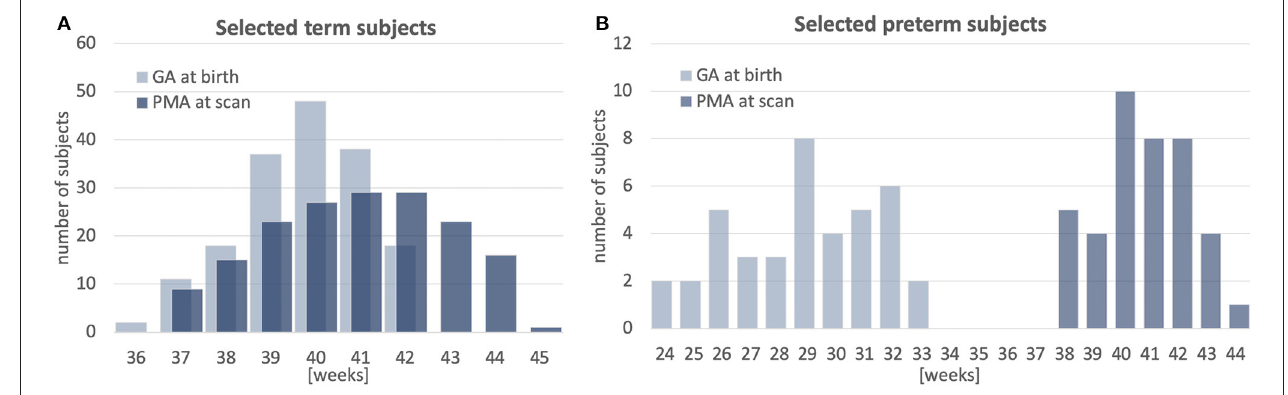
FIGURE 1 | Selected cohort of neonatal subjects from dHCP project: GA at birth and PMA at scan of 170 term subjects (A) and 40 preterm subjects (B)